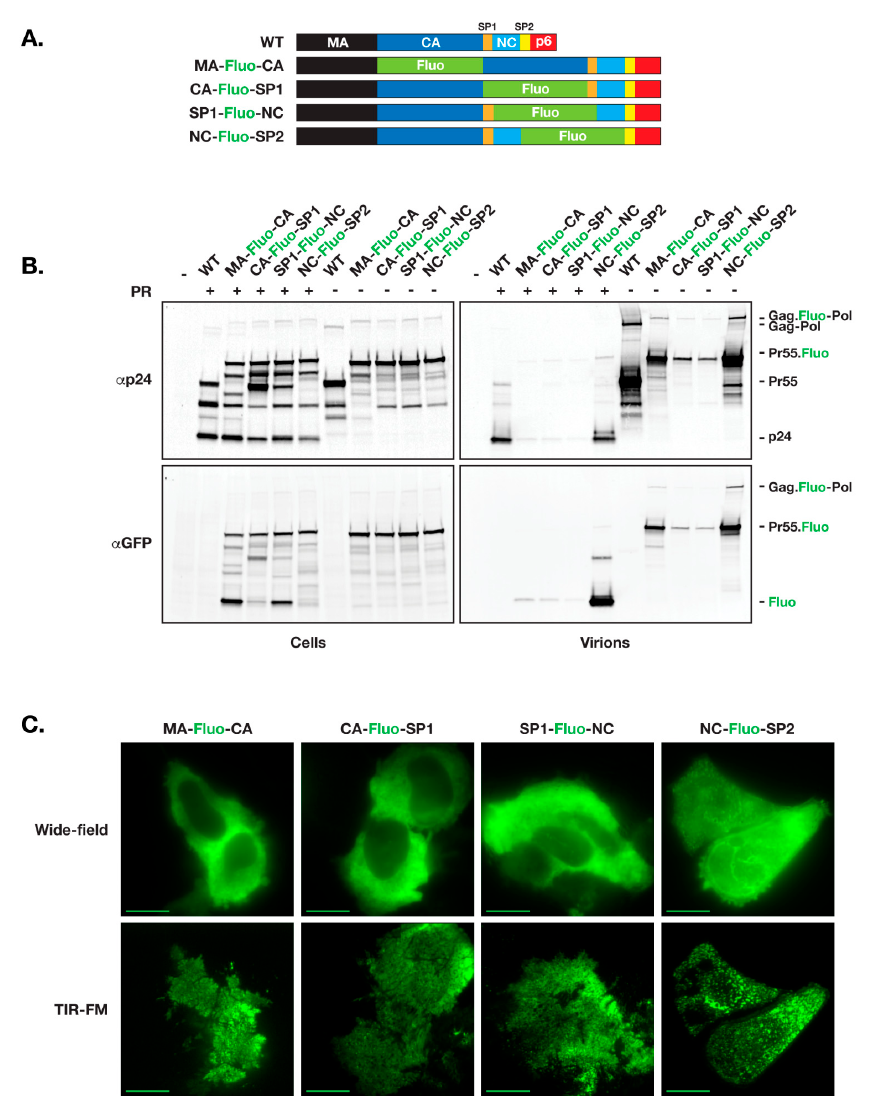
Figure 1. Construction and expression of HIV R8.2:Gag–Fluo vectors. ( A ) GFP-derived pHluorin (Fluo) is inserted into R8.2 between the domains of Gag as indicated with the protease cleavage sites duplicated accordingly for flanking both ends of the fluorescent protein. ( B ) Quantitative immunoblot analysis of R8.2 (WT, unlabeled) and R8.2:Gag–Fluo vectors expression using 293T cells. 24 h post-transfection, cells, and virions were collected and analyzed as described in the Materials and Methods section. Both R8.2 PR wild type ( + ; active protease) and PR ∆ D25N ( − ; inactive protease) were characterized. The specific primary antibodies used for immunoprobing and positions of viral proteins are indicated at left and right, respectively. ( C ) Cellular expression of R8.2:Gag–Fluo vectors was analyzed using HeLa cells. 12 h post-transfection, cells were visualized under wide-field imaging to assess cellular expression (cytoplasmic distribution), then under TIR-FM acquisition for evaluating the virions assembly on plasma membranes (dense punctae). Scale bars: 10 µ